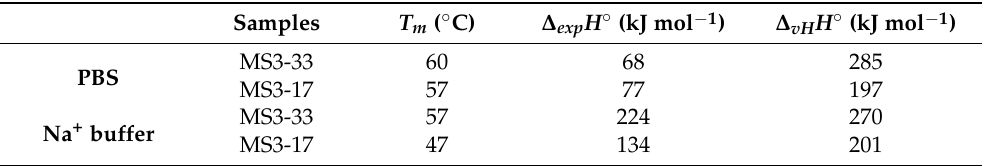
Table 3. Thermodynamic parameters obtained by the differential scanning calorimetry profiles. The error on T m determination is ± 1.0 ◦ C and on ∆ H ◦ is ±